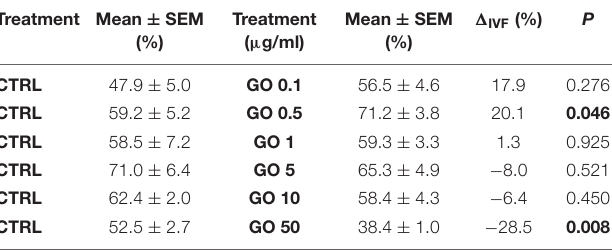
TABLE 2 | Data summarizing the IVF outcomes when spermatozoa were incubated with different GO concentrations during capacitation, with respect to their